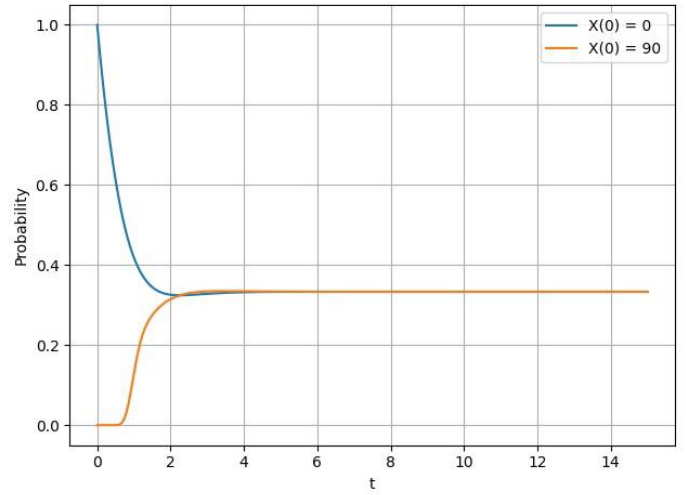
Figure 2. Probability of an empty queuing system for t ∈ [ 0,14 ]